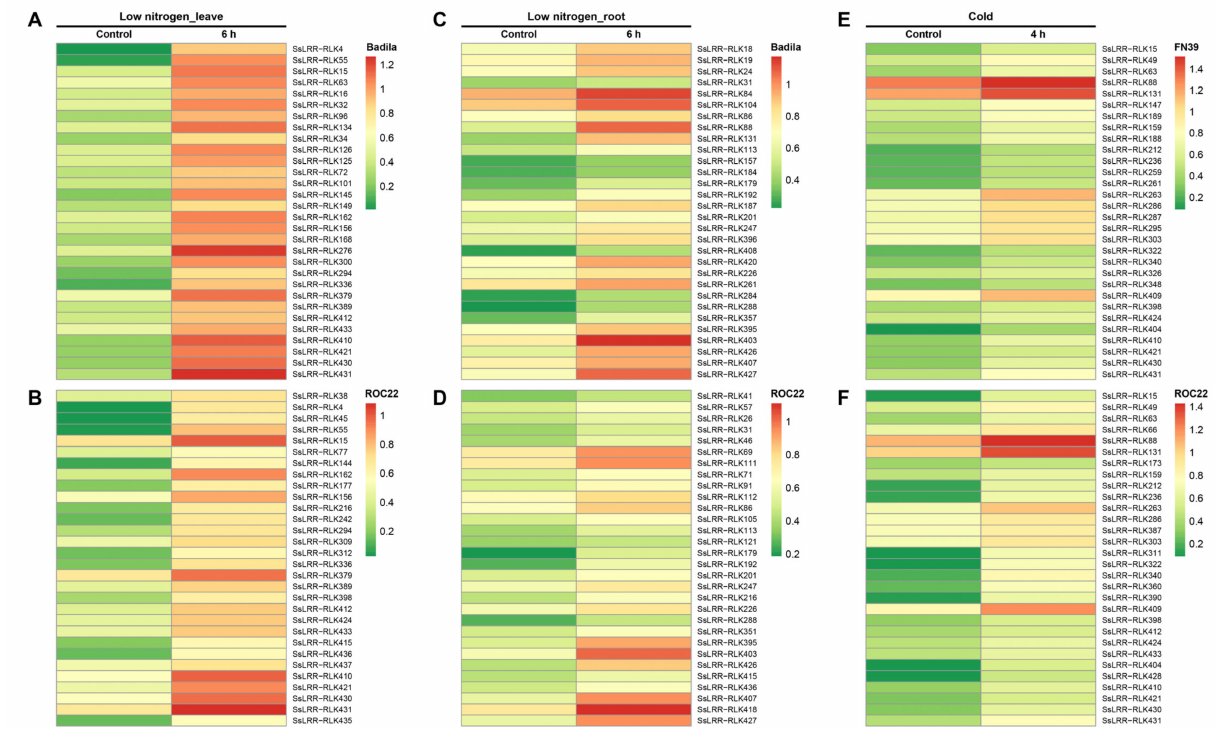
Figure 4. Heatmaps of the expression analysis of SsLRR-RLKs in response to diverse abiotic stress. The differential expression profiles in two different sugarcane varieties is shown by heatmap under ( A , B ) low nitrogen (leaf) stress, ( C , D ) low nitrogen (root) stress and ( E , F ) cold stress. Heatmap was generated based on FPKM values. The color scale represents expression values of each sample, with red showing high levels and green showing low levels of transcript